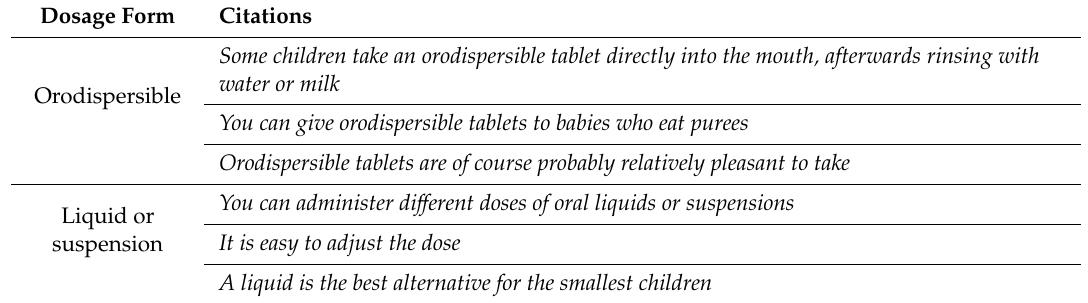
Table 3. Preferred oral dosage forms for children by healthcare